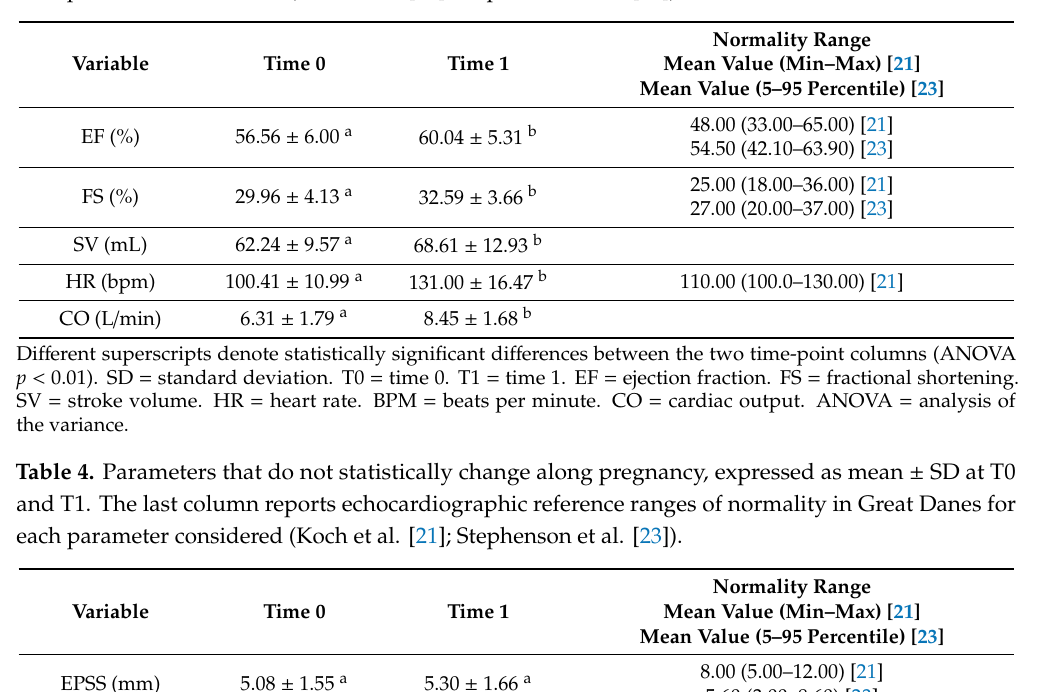
Table 3. Functional parameters and their adaptation along pregnancy, expressed as mean ± SD at T0 and T1. The last column reports echocardiographic reference ranges of normality in Great Danes for each parameter considered (Koch et al. [21]; Stephenson et al. [23]).